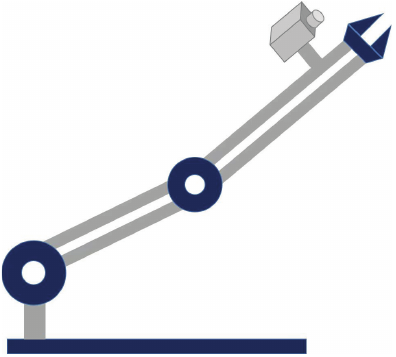
Figure 1. Eye-in-hand configuration of 2-DOF robot manipulator.